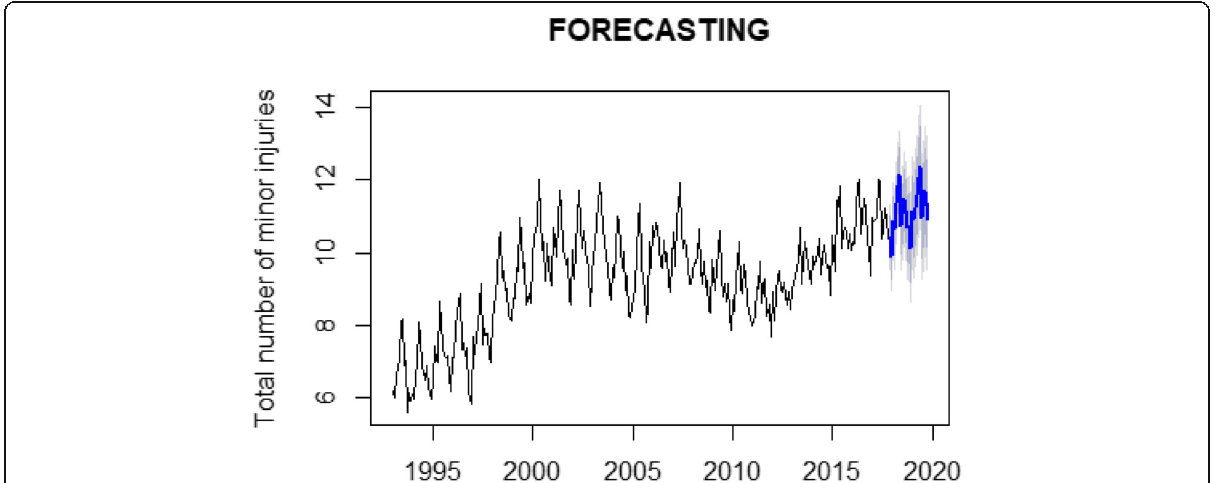
Fig. 1 The number of minor injuries on Spanish roads between January 1993 and December 2017